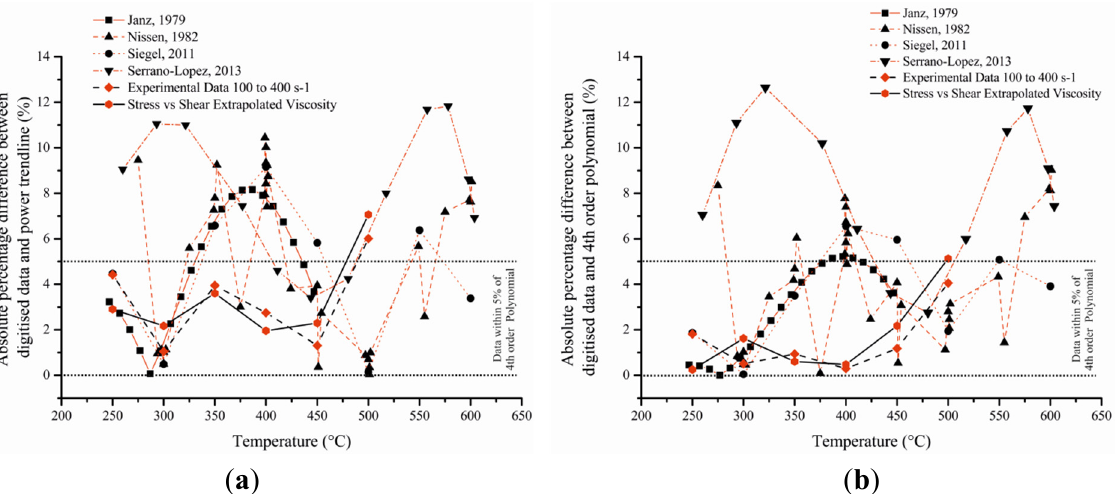
Figure 5. Absolute percentage of digitised data against power trend line ( a —Graph) and 4th order polynomial ( b —Graph) where the temperatures of the obtained data as well as experimental and extrapolated (Figure 3b—Line Gradient) numbers were used to calculate the theoretical values with the two different equations.